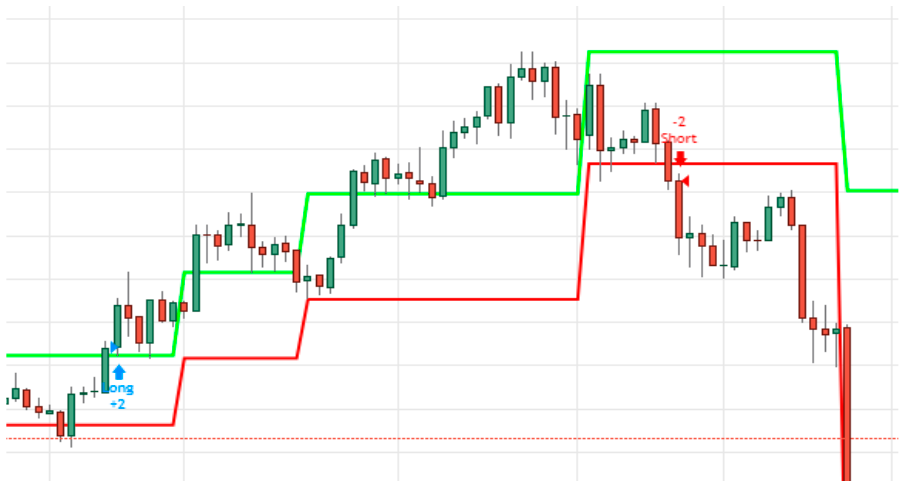
Figure 2. Darvas boxes algorithmic trading strategy. Notes: Every candlestick in Figure 2 represent the high/low open/close Bitcoin daily prices. A green daily candle means that the close price is above the opening price and a red candle means that the close price is lower than the opening price. The green and red lines indicate the upper and lower boundaries of Darvas’s boxes.